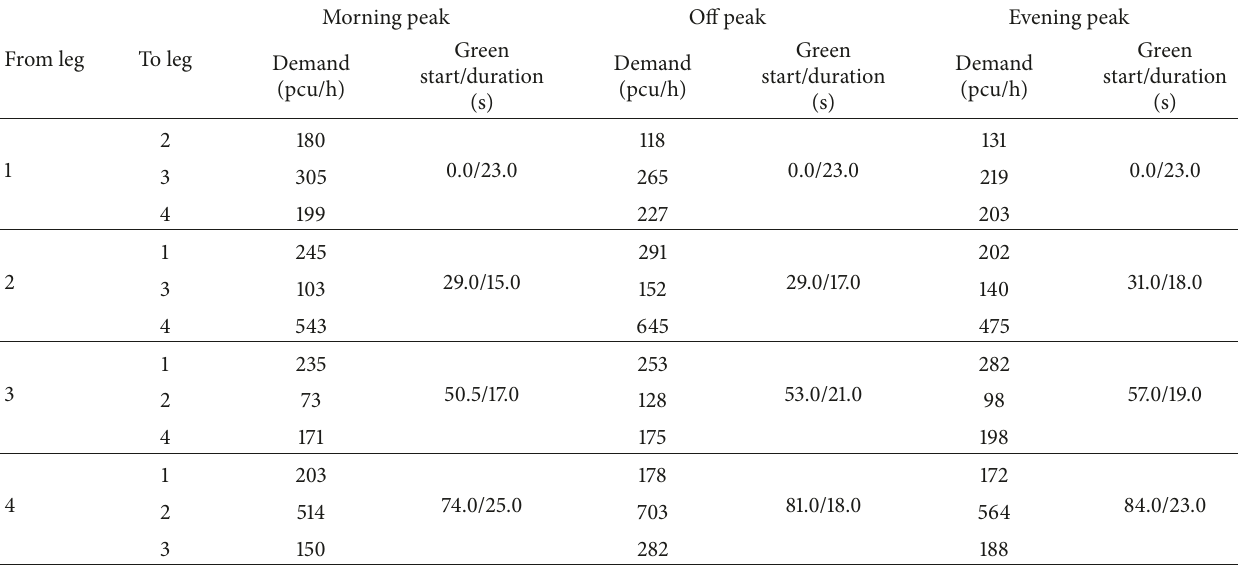
Table 7: Traffic demand pattern and existing traffic signal settings.